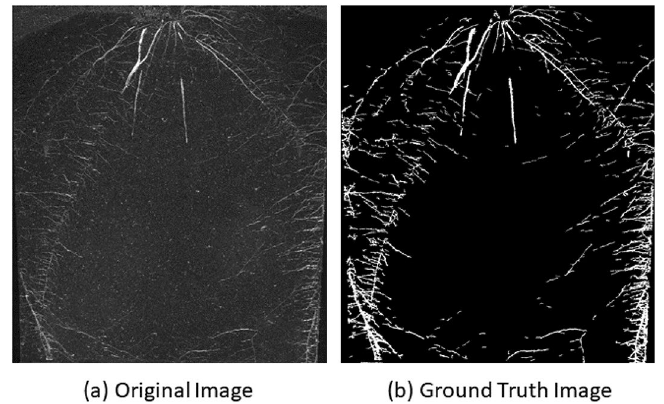
Figure 2. Exemplary root image from IPK plant phenotyping system: ( a ) maize plant roots 28 days after sowing, ( b ) corresponding root segmentation from soil performed using